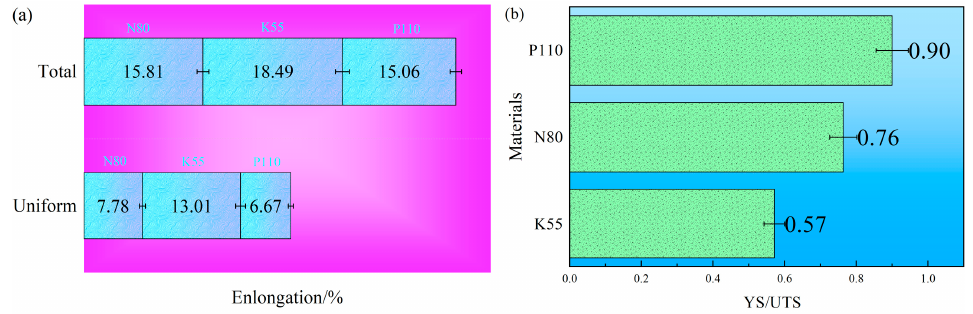
Figure 4. Comparison between the elongation ( a ) and YS/UTS ( b ) of three types of casing drilling steels.